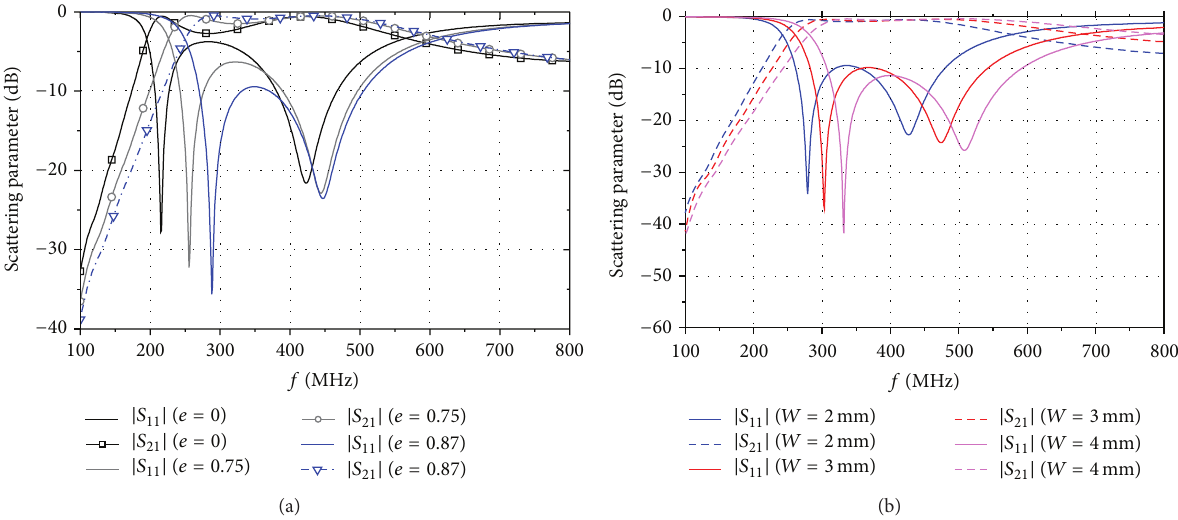
Figure4:Scatteringparameterscalculatedbymeansoffull-wavesimulationsduringtheoptimizationprocessoftheresonators.Optimization of (a) the eccentricity 𝑒 and (b) the width, 𝑊 , of the loop.